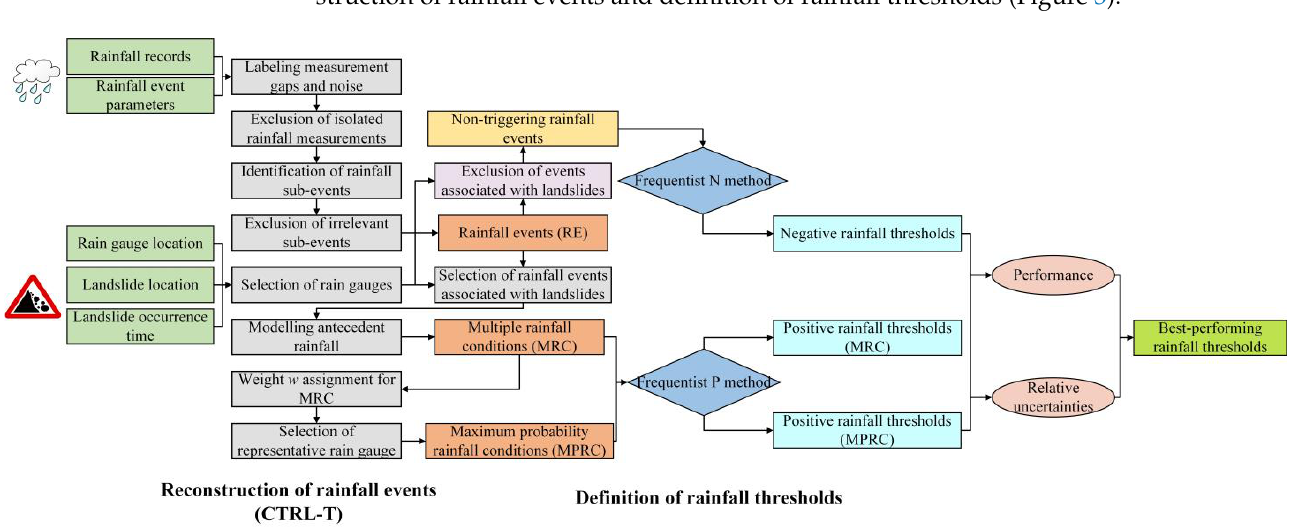
Figure 3. Flowchart of the procedure adopted in this study.